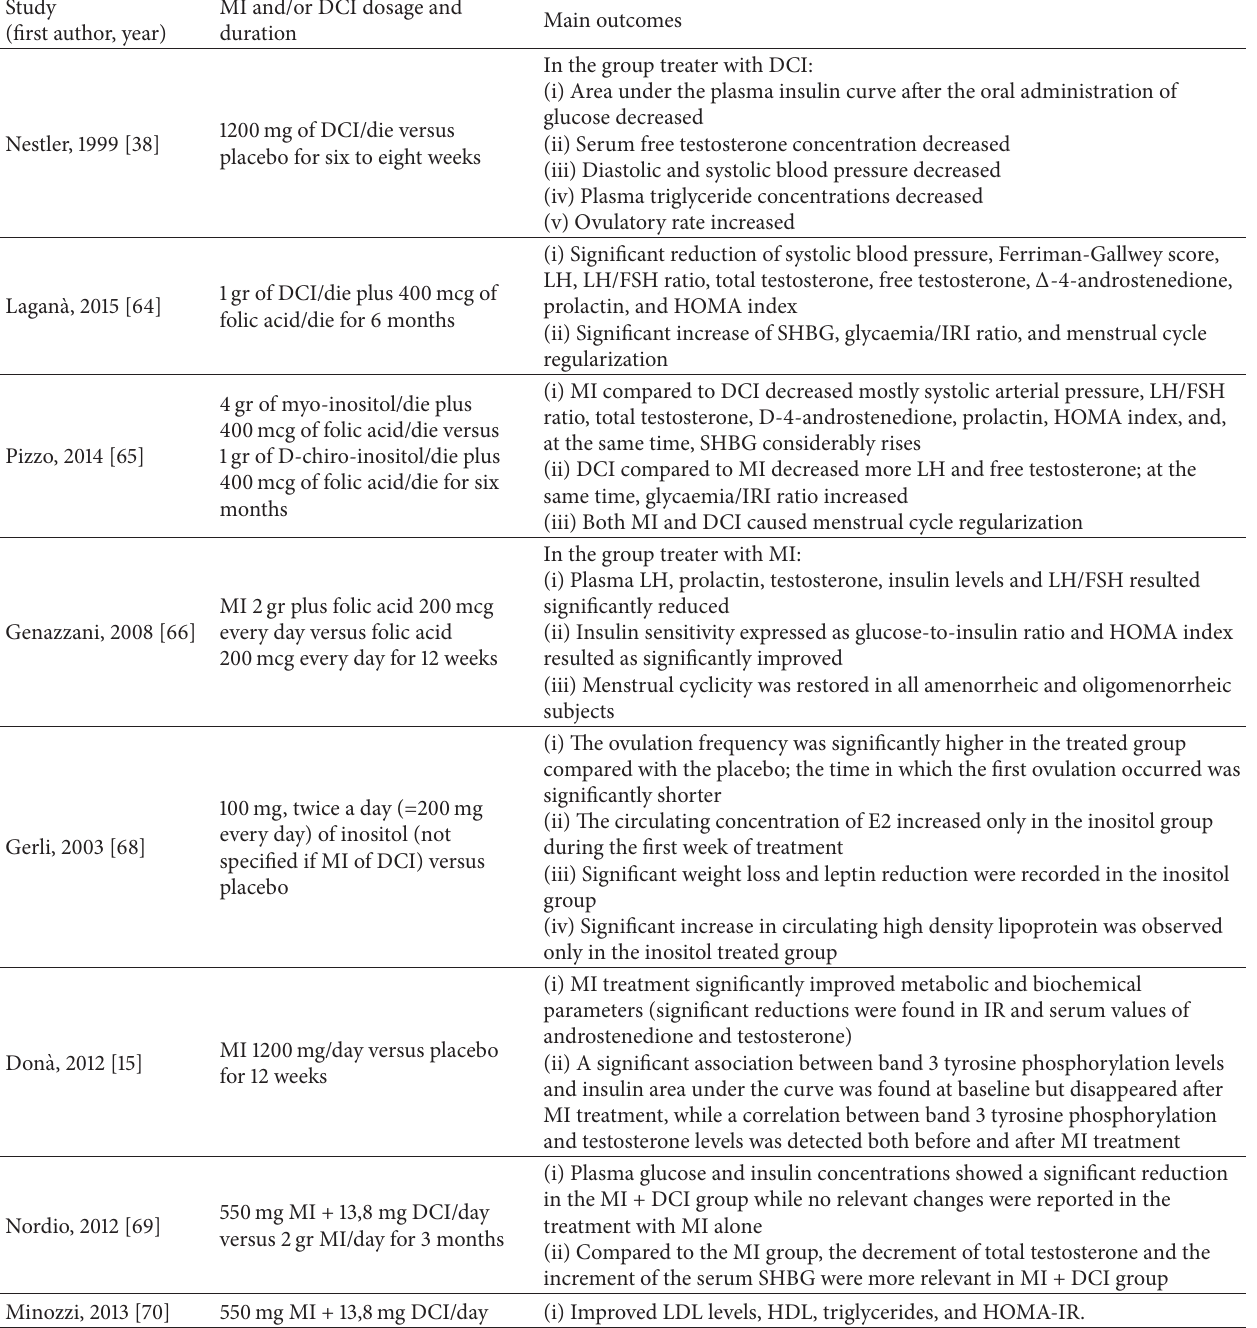
Table 2: Summary of the reported studies about myo-inositol and D-chiro-inositol use in PCOS treatment.